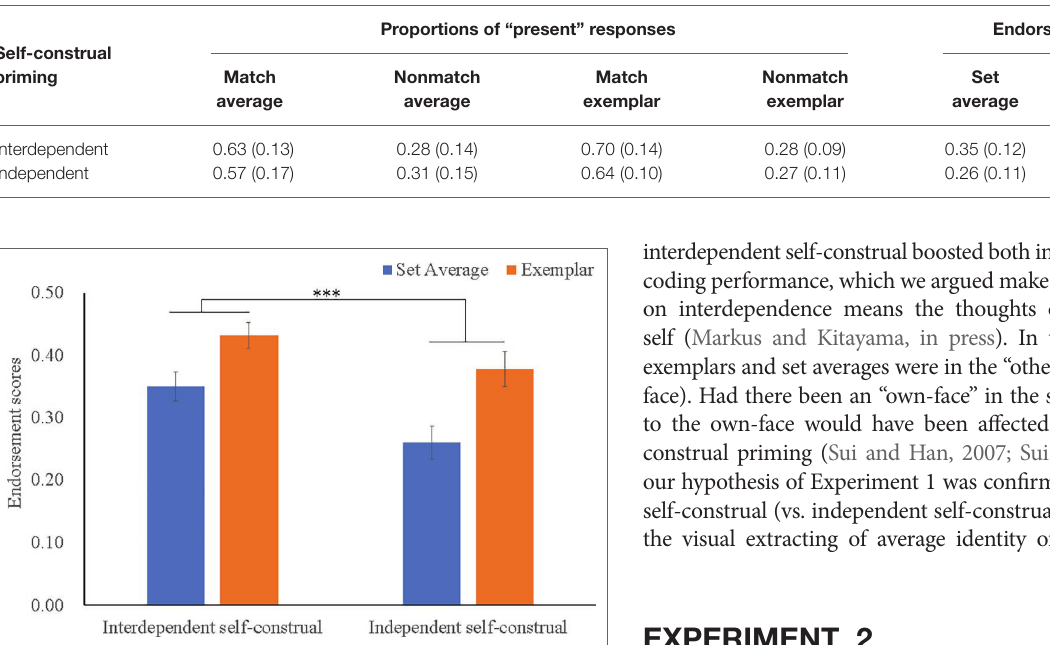
FIGURE 2 | Endorsement scores as a function of Prime Type × Testimage Type in Study 1. Error bars refer to standard error of mean (SME). *** refers to the significant Testimage Type effect ( p <